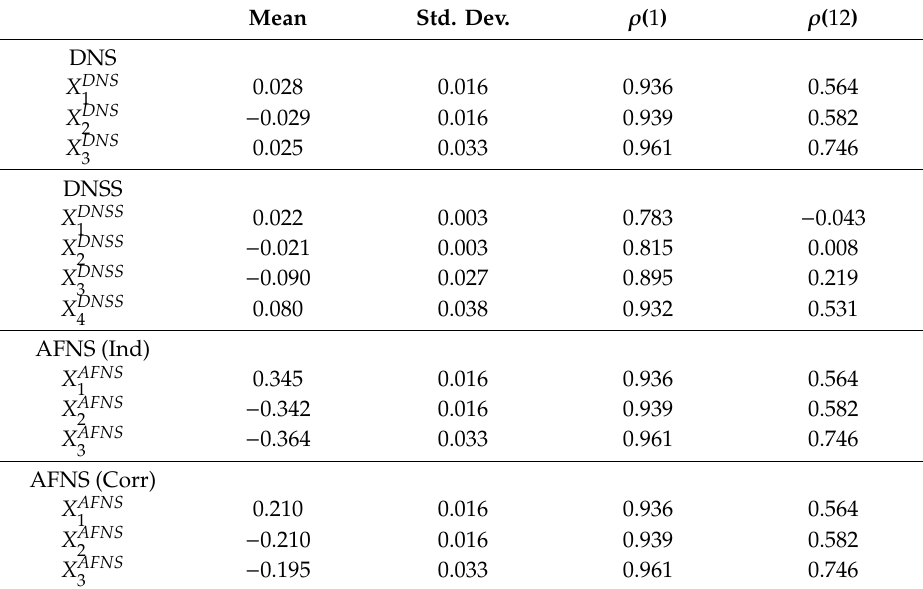
Table 1. Mean, standard deviation, and auto-correlation of the estimated state variables.